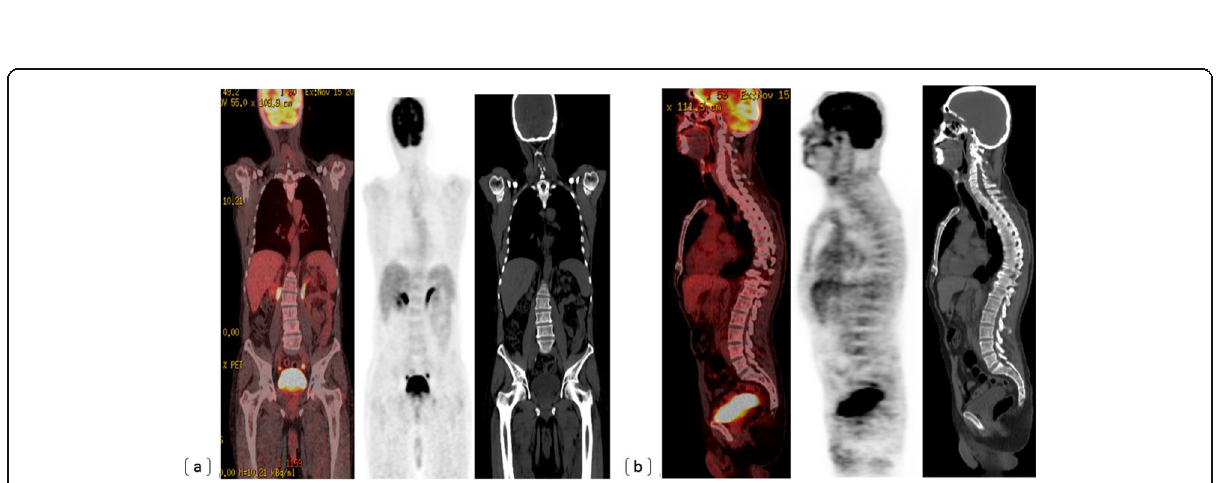
Fig. 10 A 56-year-old male patient pathologically proven lymphoplasmacytic lymphoma ( a ) and ( b ) are initial PET/CT fused images, PET images, and CT images in the coronal ( a ) and sagittal ( b ) planes showing no metabolically active lesions. BMB was positive for